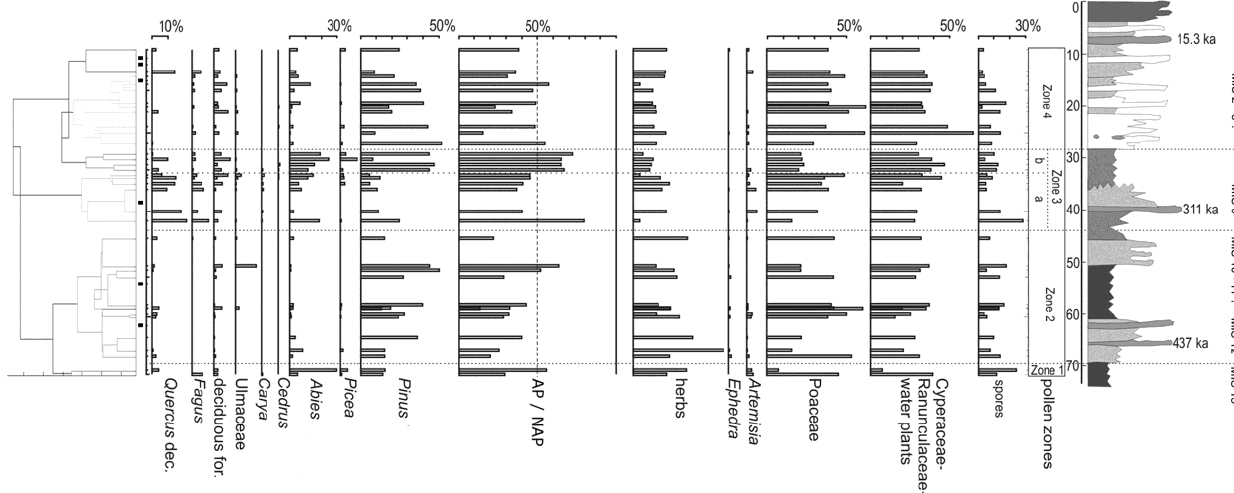
Fig. 3. Synthesized pollen diagram of core S6 from Boiano, with position of barren samples ( (cid:4) ). Taxa are grouped according to their ecological significance (after Orain et al., 2012, 2013).